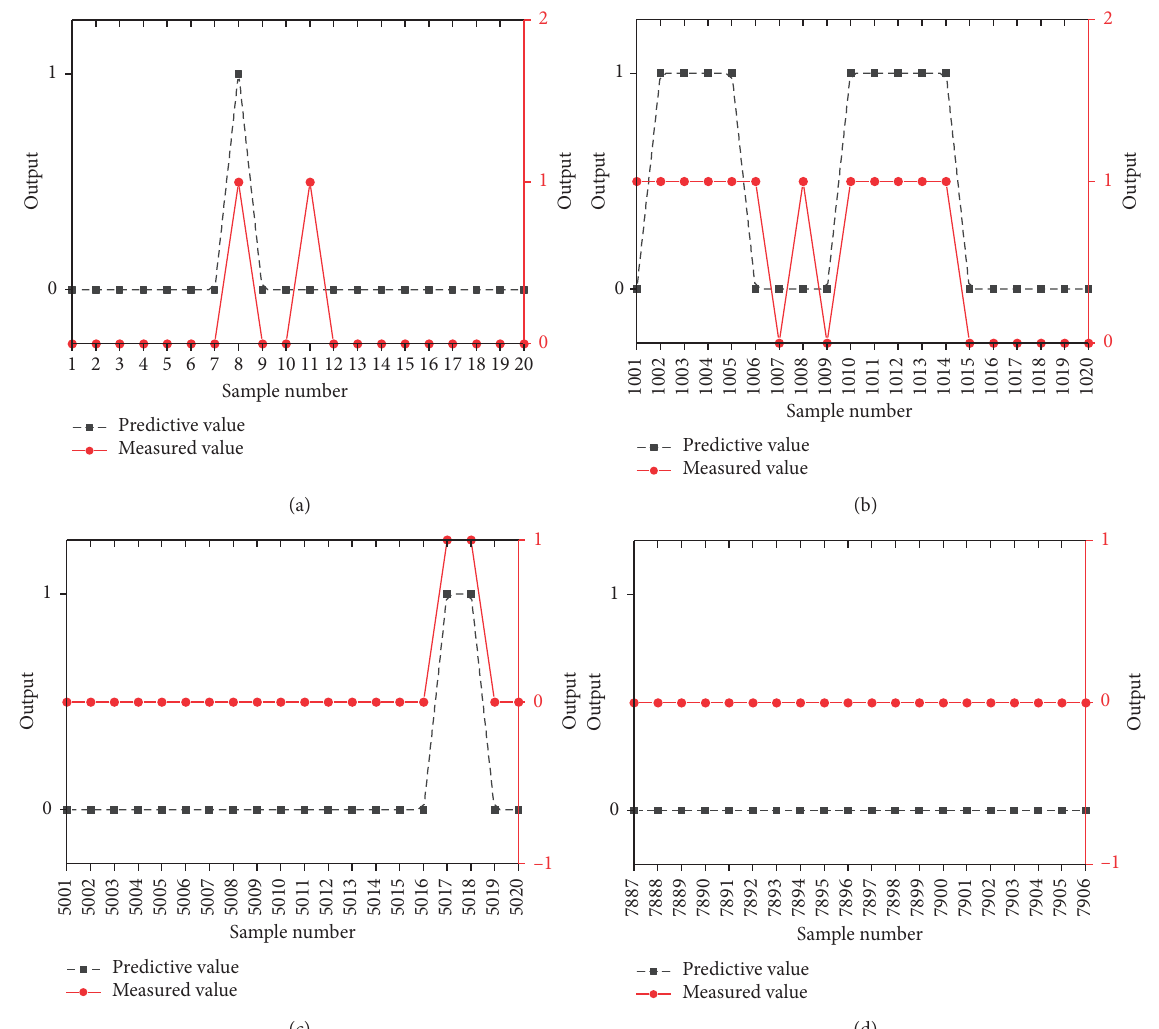
Figure 7: Comparison chart of SVM predicted and actual values (a part of the sample): (a) number: 1–20, (b) number: 1001–1020, (c) number: 5001–5020, and (d) number: